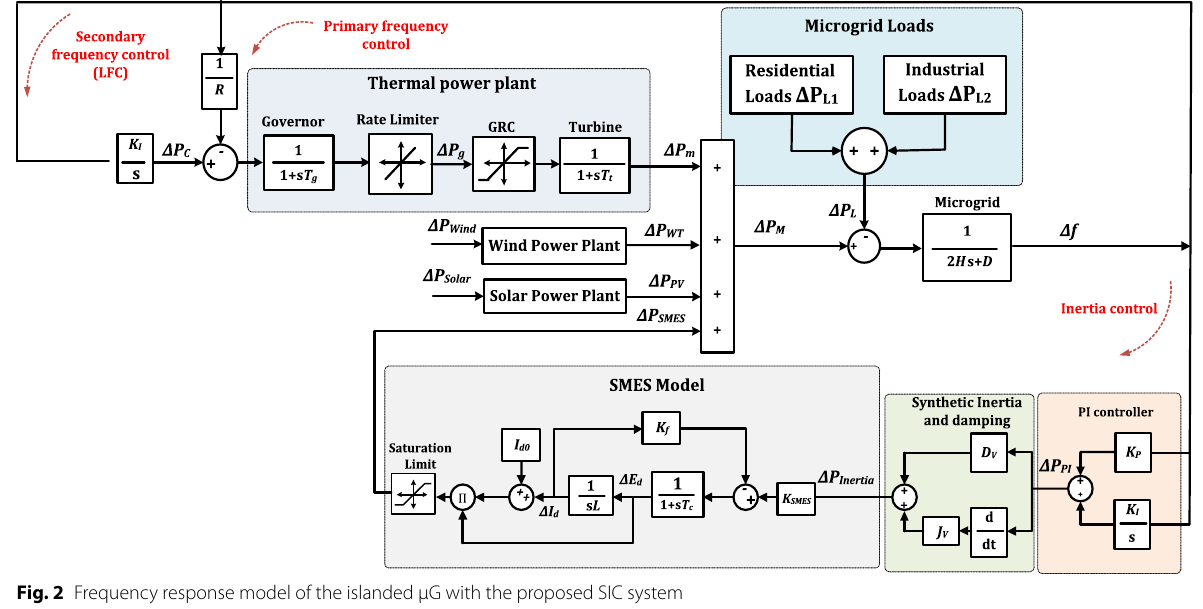
Fig. 2 Frequency response model of the islanded µG with the proposed SIC system